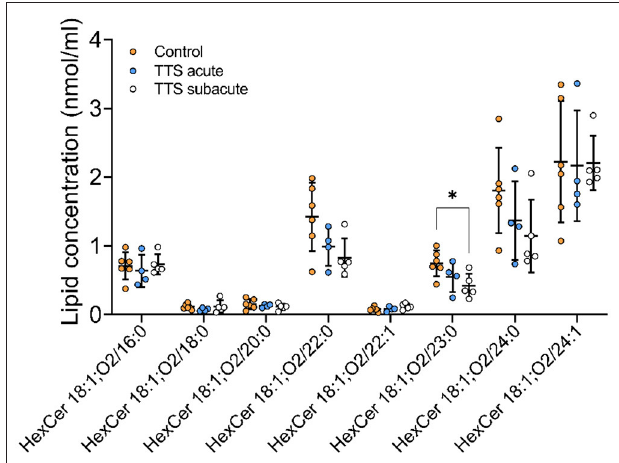
FIGURE 7 | Composition of individual HexCer lipid species in the acute TTS, subacute TTS, and control groups. Values are represented as nmol/ml. Values are mean ± SD, P -value: * P < 0.05. Where significance is not mentioned, values are considered as being not significant. HexCer, Hexosylceramide; TTS, Takotsubo syndrome.